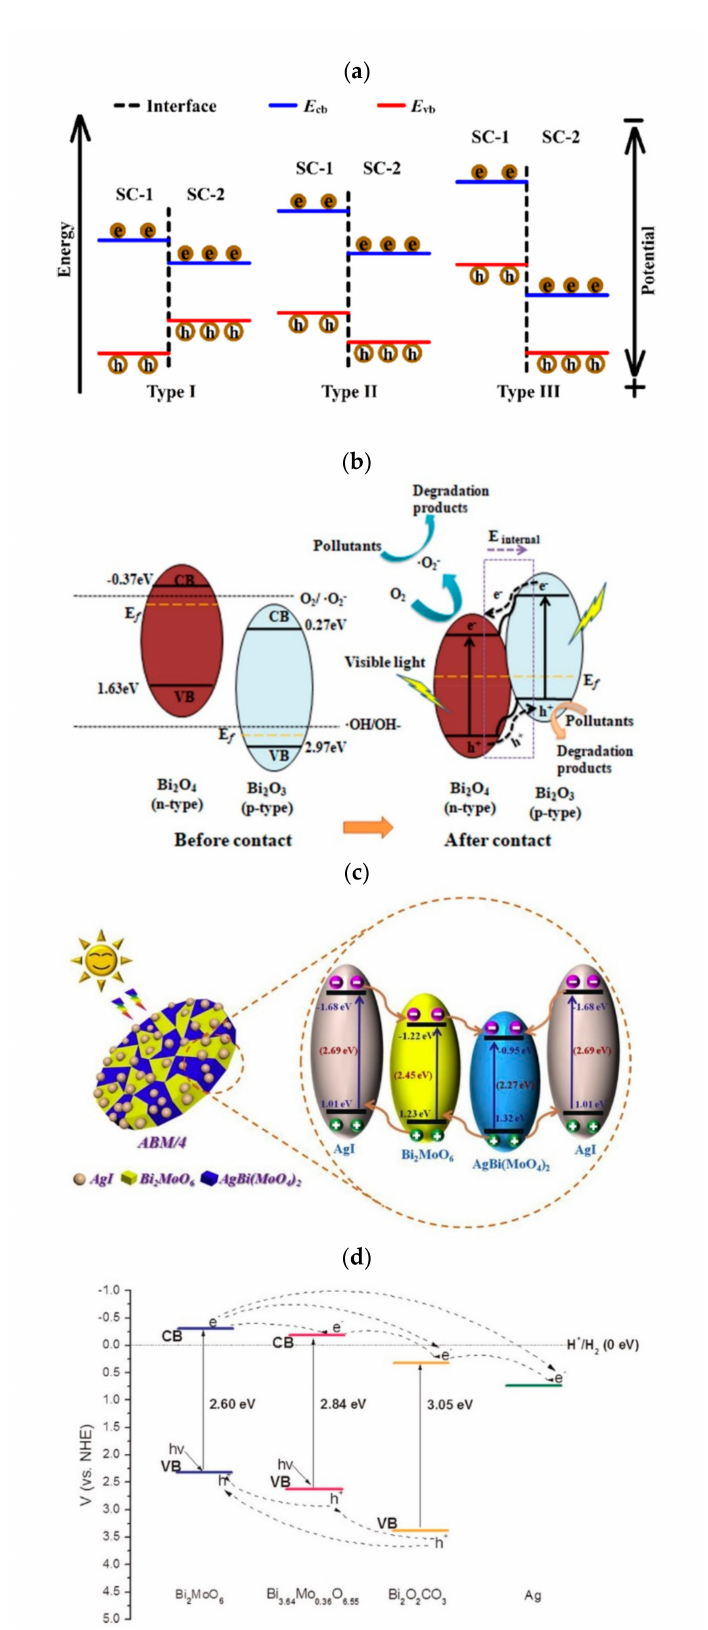
Figure 5. Illustrated ( a ) type of band alignment between two semiconductors in a heterojunction [51], ( b ) binary [52], ( c ) ternary [53], and ( d ) quaternary coupling heterojunctions